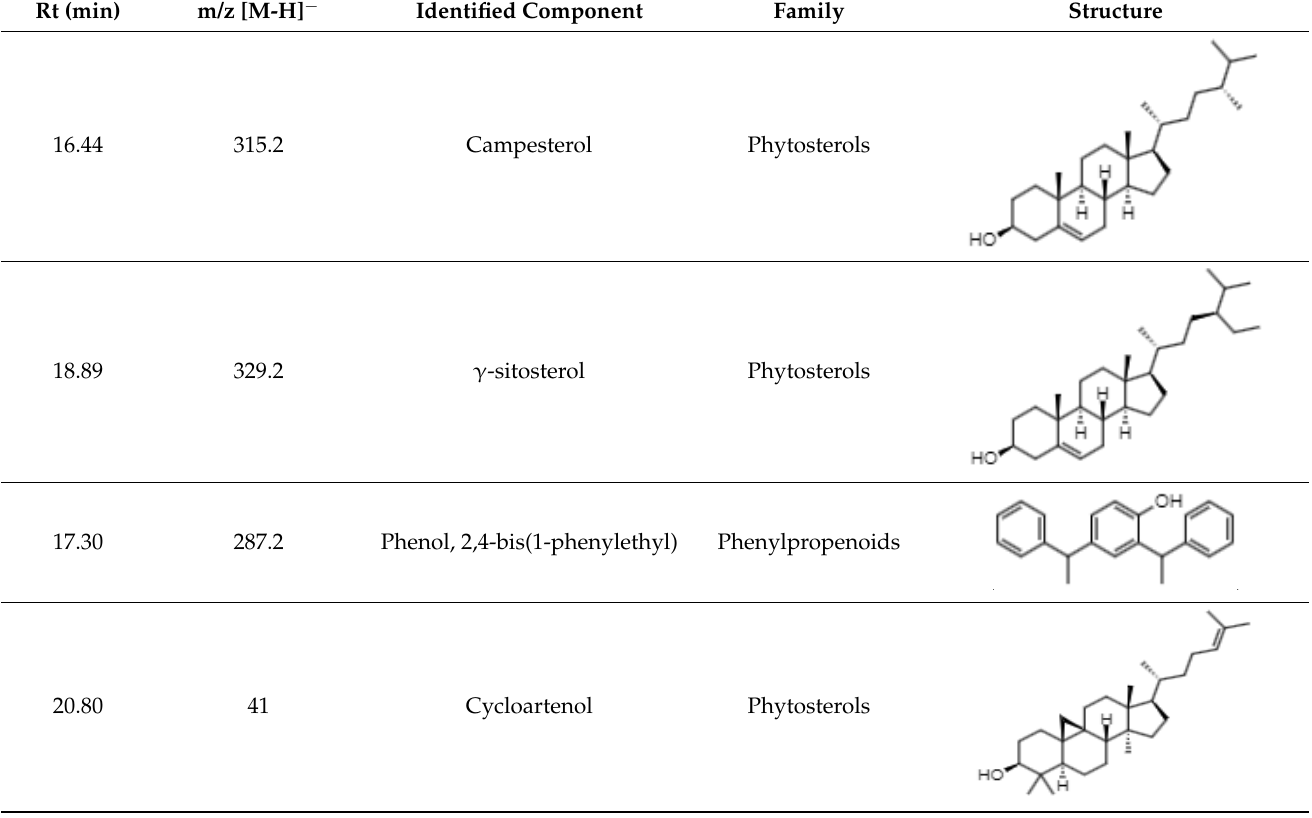
Table 3. Components identified by reverse-phase high-performance liquid chromatography (RP-HPLC-ESI-MS) in the extract of E. hyemale . Rt, retention time; m/z, mass-to-charge ratio; min, minutes.